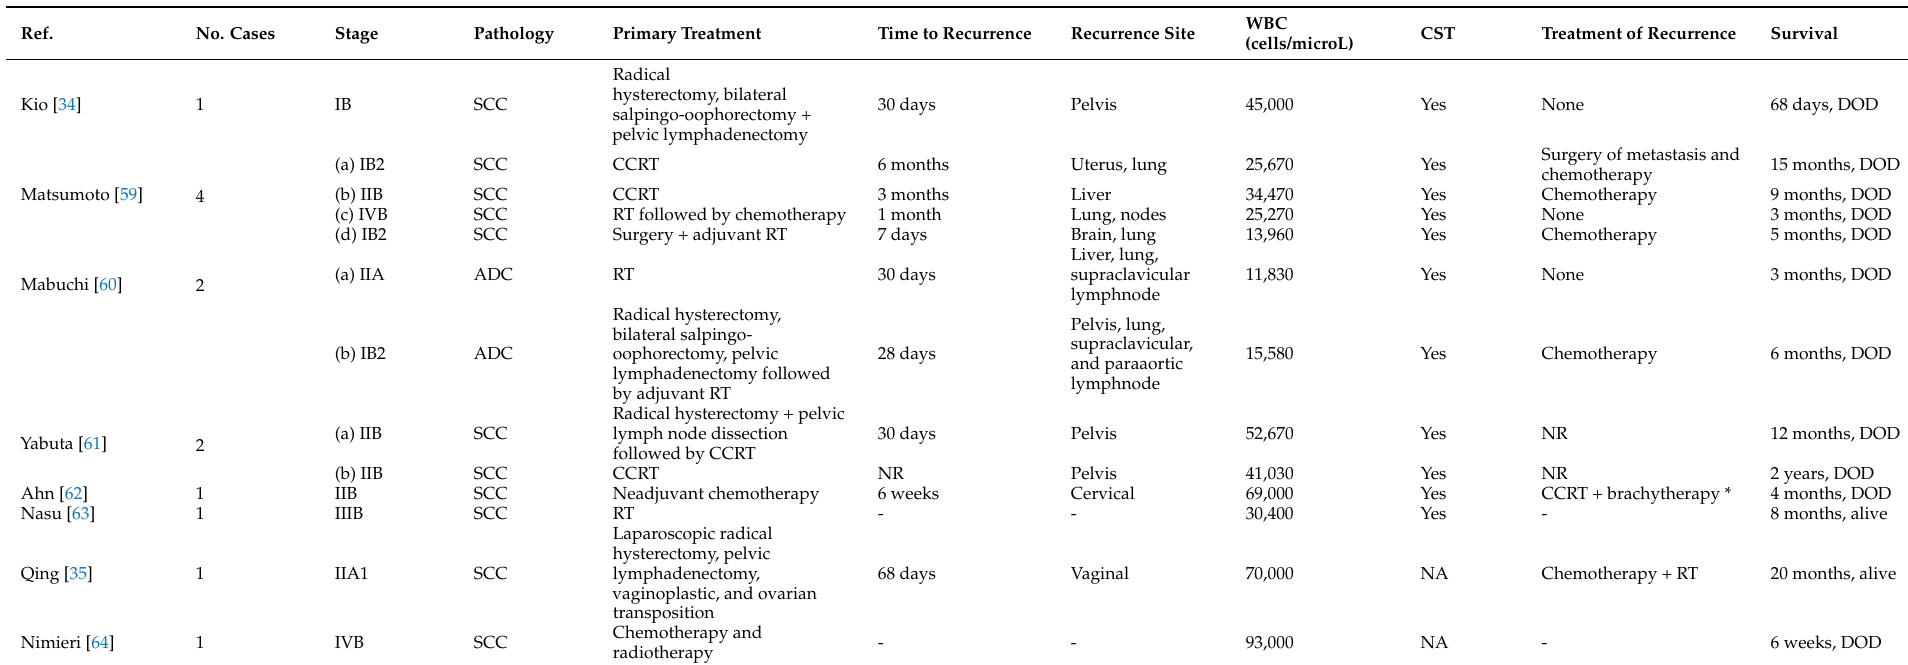
Table 2. List of similar cases or study population on paraneoplastic leukocytosis in cervical cancer available in literature.